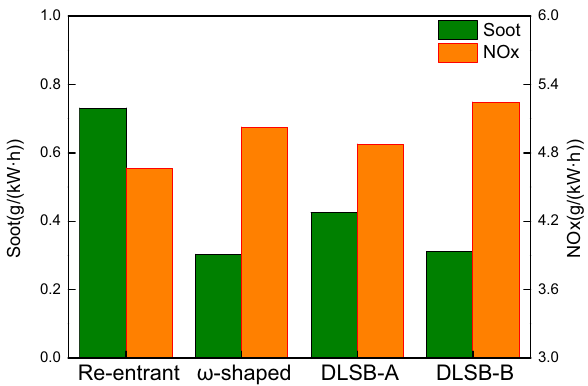
Figure 14: The traces of in - cylinder pressure and heat release rates for di ff erent diameter - to - depth ratios.